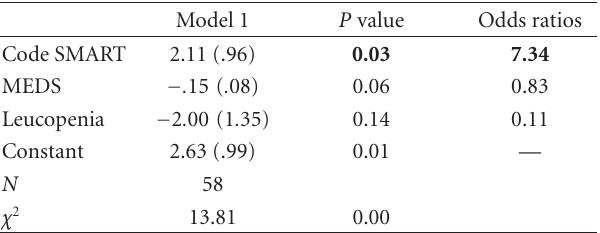
Table 5: Model 1—logistic regression of mortality controlling for + / − use of Code SMART, MEDS, and leucopenia.